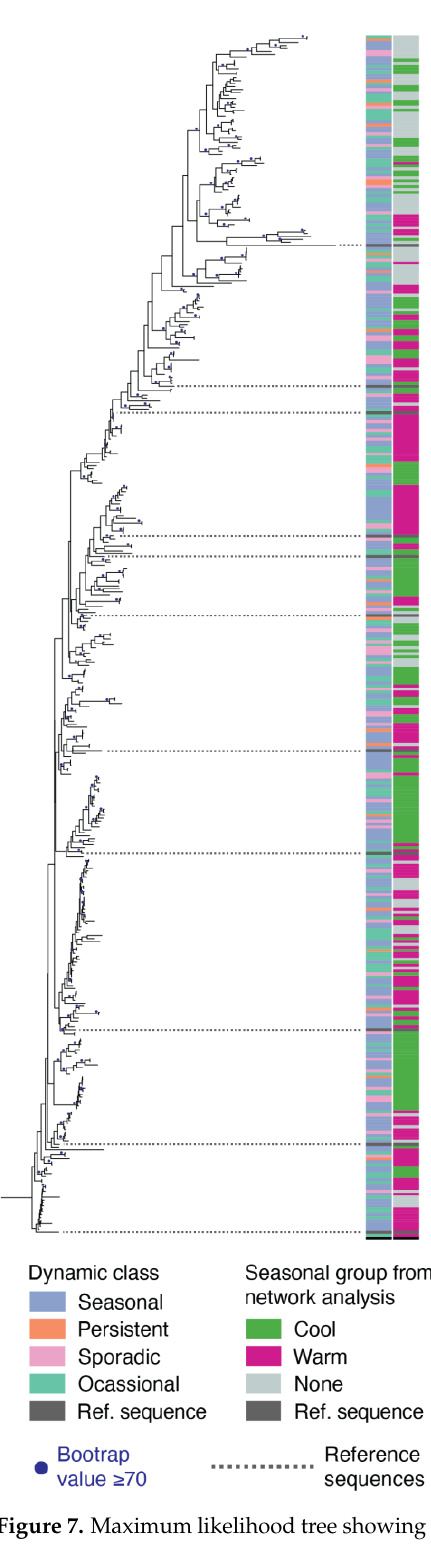
Figure 7. Maximum likelihood tree showing assembled gp43 sequences and reference sequences. Tree is rooted using the gp43 sequence for E. coli T4 phage. Colored blocks to the right of the tree indicate to which dynamic class (left column, e.g., see Figure 2) or seasonal group (right column; based on network analysis affiliation from Figure 6) each species belongs. Isolate gp43 reference sequences, which were not detected in metagenomes, are indicated with dark gray blocks, and dashed lines show the location of these reference sequences in the tree.